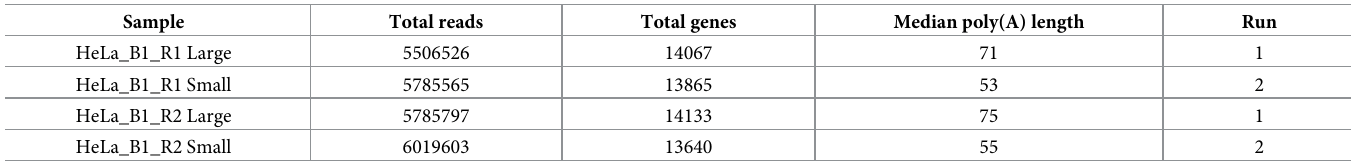
Table 3. Poly(A)-seq profiles of Large and Small